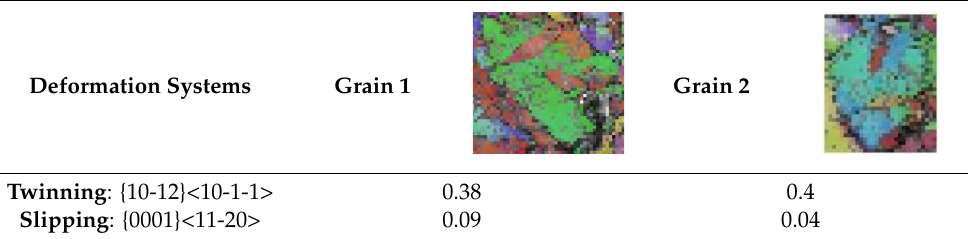
Figure 5. OIM for {10-12}<10-1-1> twinning in one globular α grain. ( a ) OIM in the rectangle region of Figure 4e. ( b ) Orientation of unit cell for matrix (green region in ( a )). ( c ) Orientation of unit cell for twinning (red region in (Figure 5a)), t he “X” stands for the normal direction of the plate.